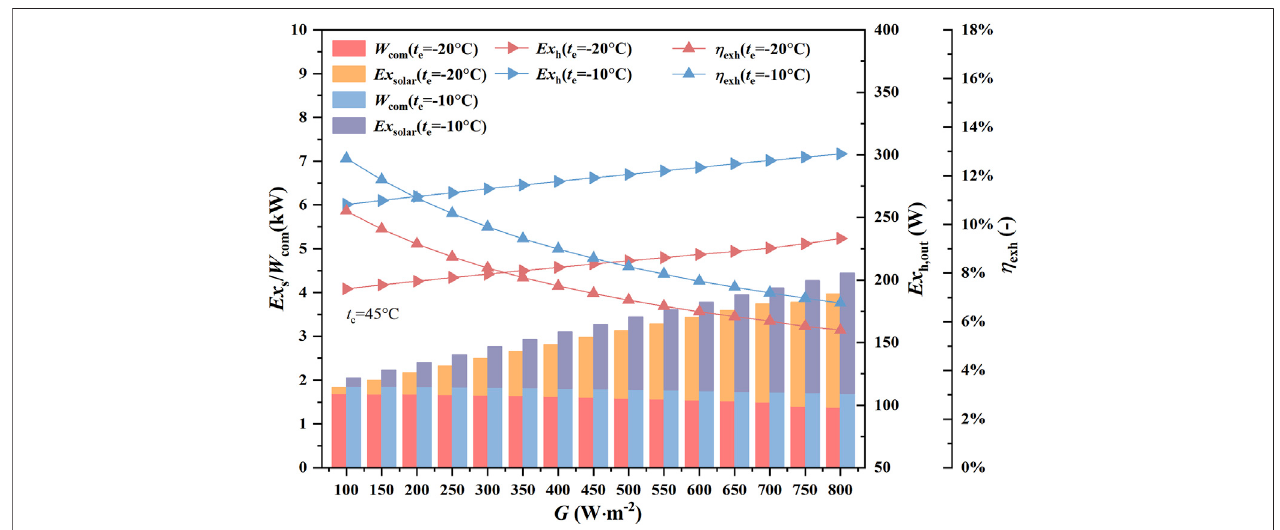
FIGURE 8 | Variation of system exergy performance with solar radiation intensity.